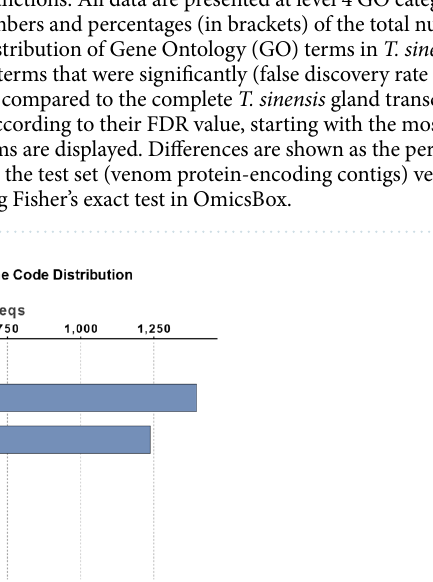
using mass spectrometry, and the expressed proteins were identified when their sequences matched with the translated transcripts (contigs) of the venom gland transcriptome. Proteins containing a putative signal peptide for extracellular localization and predicted cleavage sites were reported as venom-expressed components. All putative (predicted from the transcriptome) or expressed (confirmed by the proteomic approach) proteins identi- fied as venom protein components were further compared to Nasonia vitripennis venom proteins described by de